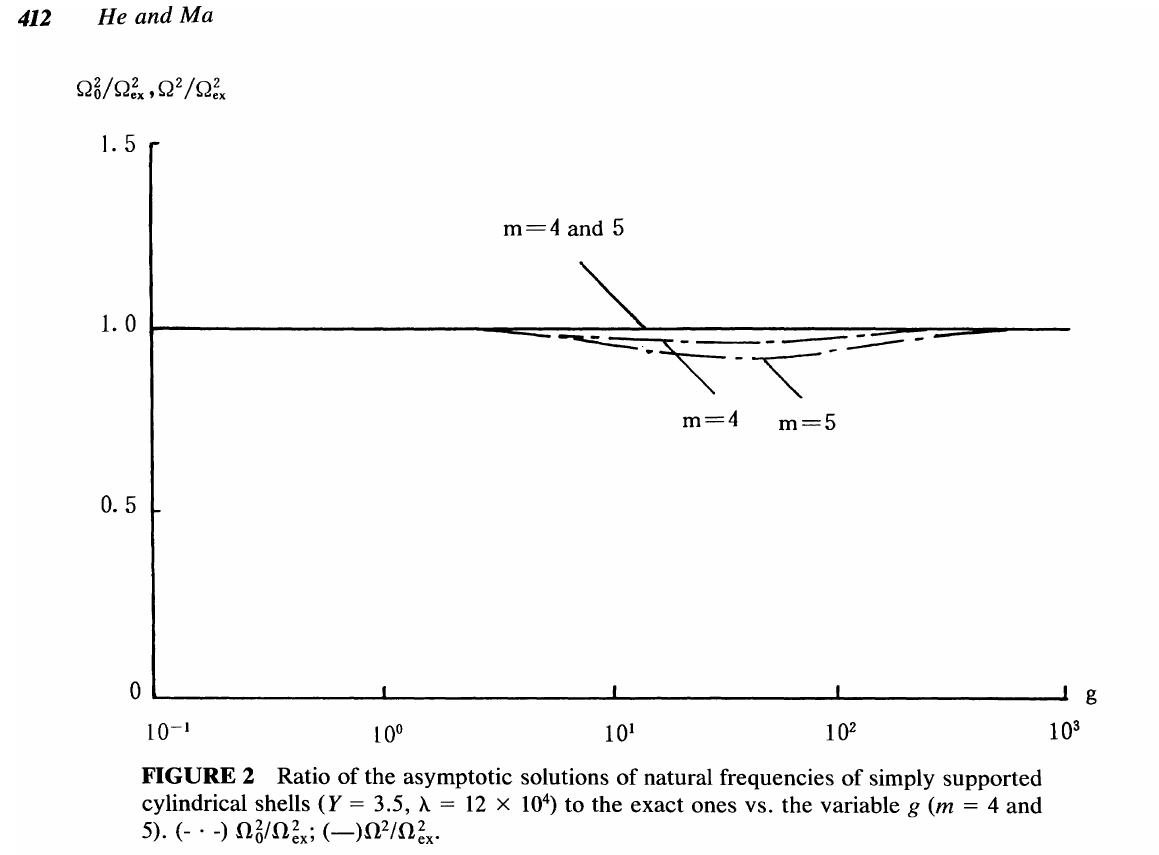
FIGURE 2 Ratio of the asymptotic solutions of natural frequencies of simply supported cylindrical shells (Y = 3.5, A = 12 X 10 4) to the exact ones vs. the variable g (m = 4 and 5). (- . -) nfitn~x;